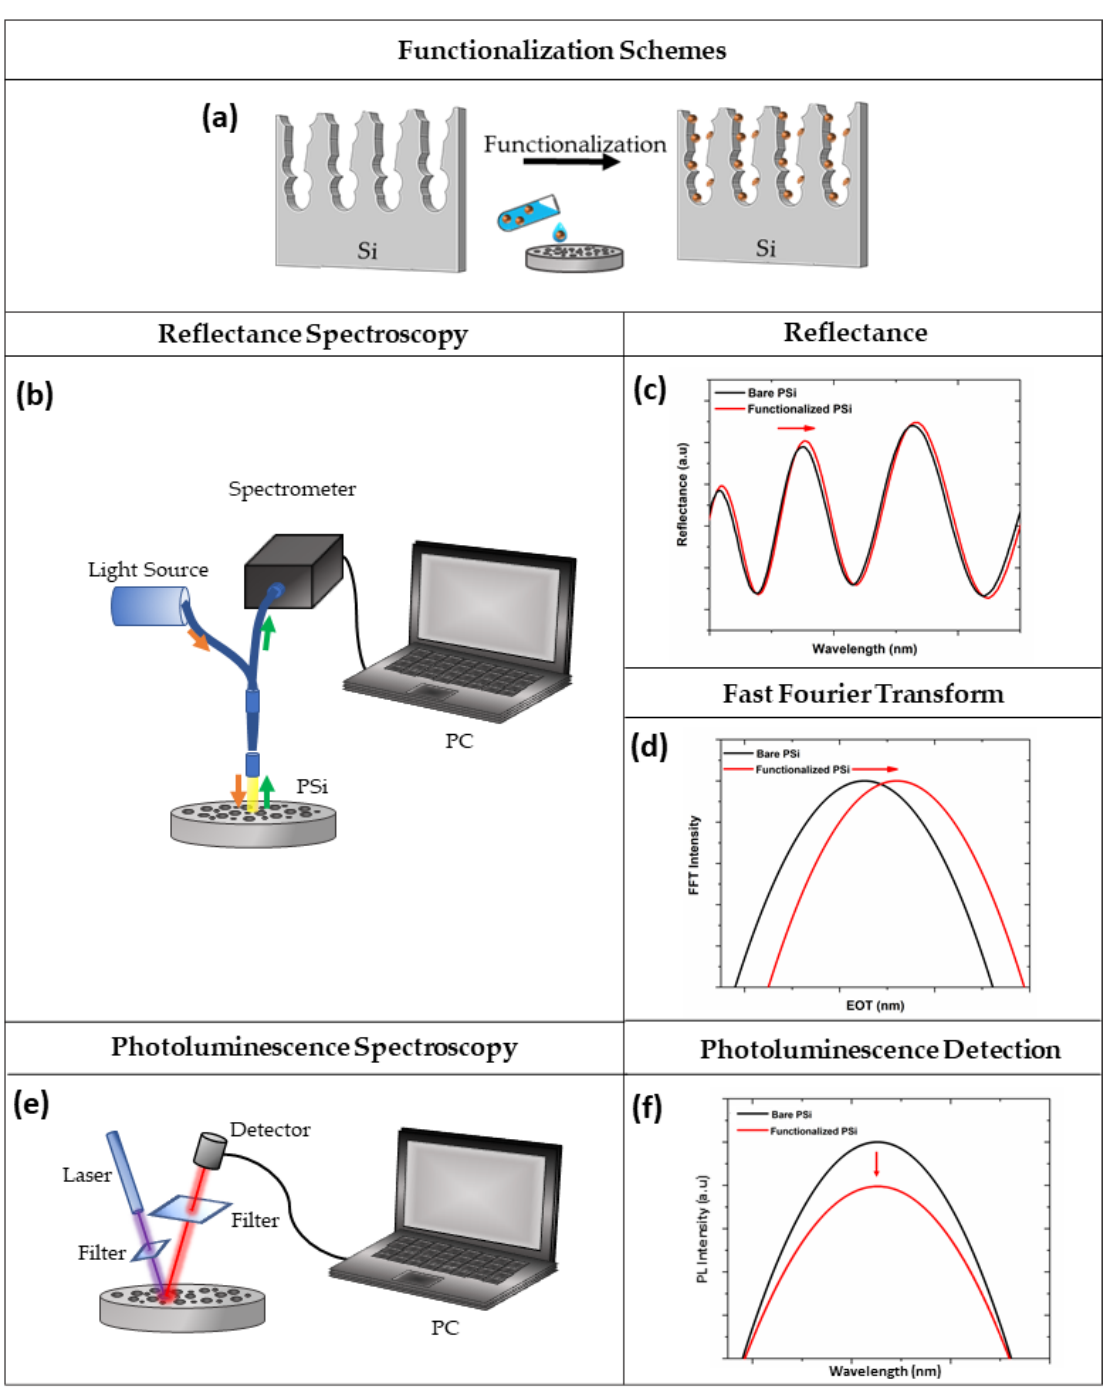
Figure 3. ( a ) Functionalization scheme of PSi; ( b ) optical setup for spectroscopy reflectometry, ( c ) reflectivity, and ( d ) FFT spectra before (black line) and after (red line) PSi functionalization; ( e ) optical setup for photoluminescence spectroscopy, and ( f ) corresponding spectra before (black line) and after (red line) the functionalization procedure.